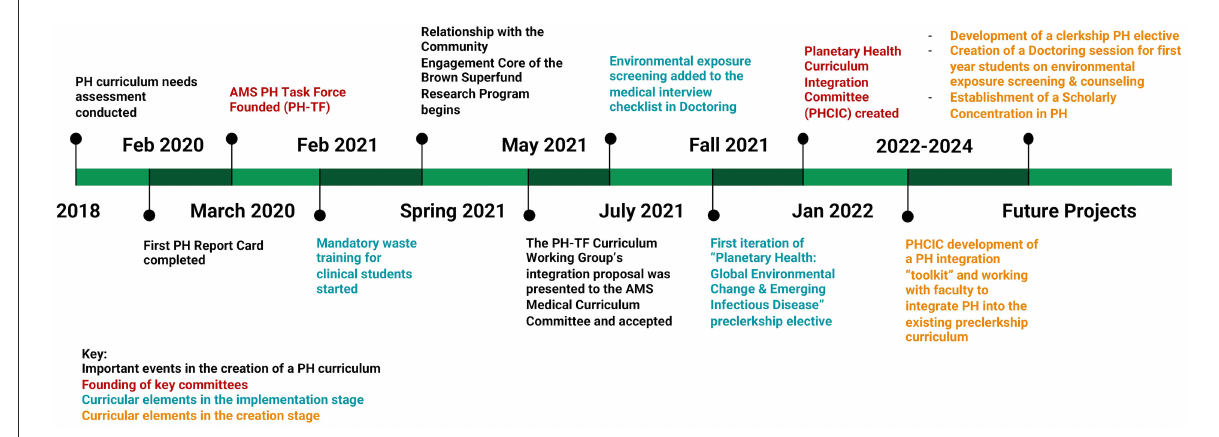
FIGURE1 Timeline of planetary health educational initiatives at the Warren Alpert Medical School of Brown University.